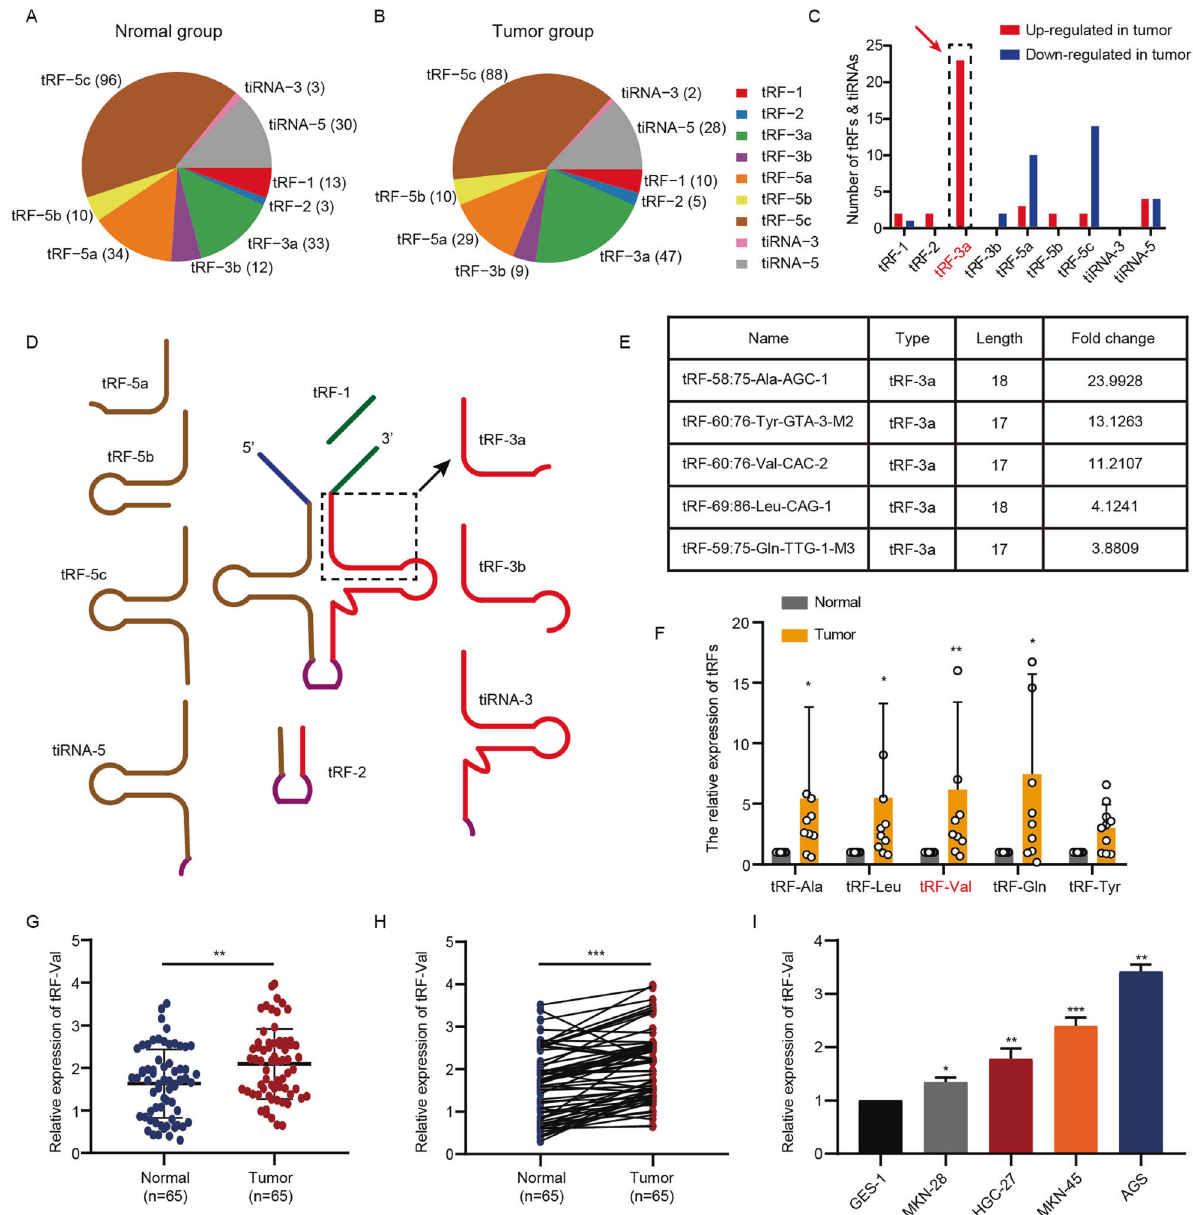
Fig. 2 tRF-Val is signi fi cantly upregulated in GC. A , B Distributions of different types of tRFs and tiRNAs in normal and tumor groups. C The numbers of signi fi cantly upregulated and downregulated (set P < 0.05) tRFs and tiRNAs were separately calculated in GC, and tRF-3a was the main upregulated type (23/38). D Location of tRF-3a in tRNA-derived fragments. E The fi ve of tRF-3a with the highest fold change was selected for further qRT-PCR veri fi cation. F tRF-Val was the most signi fi cantly upregulated tRF in 10 GC tissues compared with matched normal tissues. G , H Relative expression of tRF-Val in 65 GC tissues and paired normal tissues was detected by qRT-PCR. I Relative expression of tRF-Val in GC cell lines and GES-1 was detected by qRT-PCR. Data were shown as mean ± SD. (Mann – Whitney U test, student ’ s t -test, and paired t -test, * P < 0.05, ** P < 0.01, and *** P <